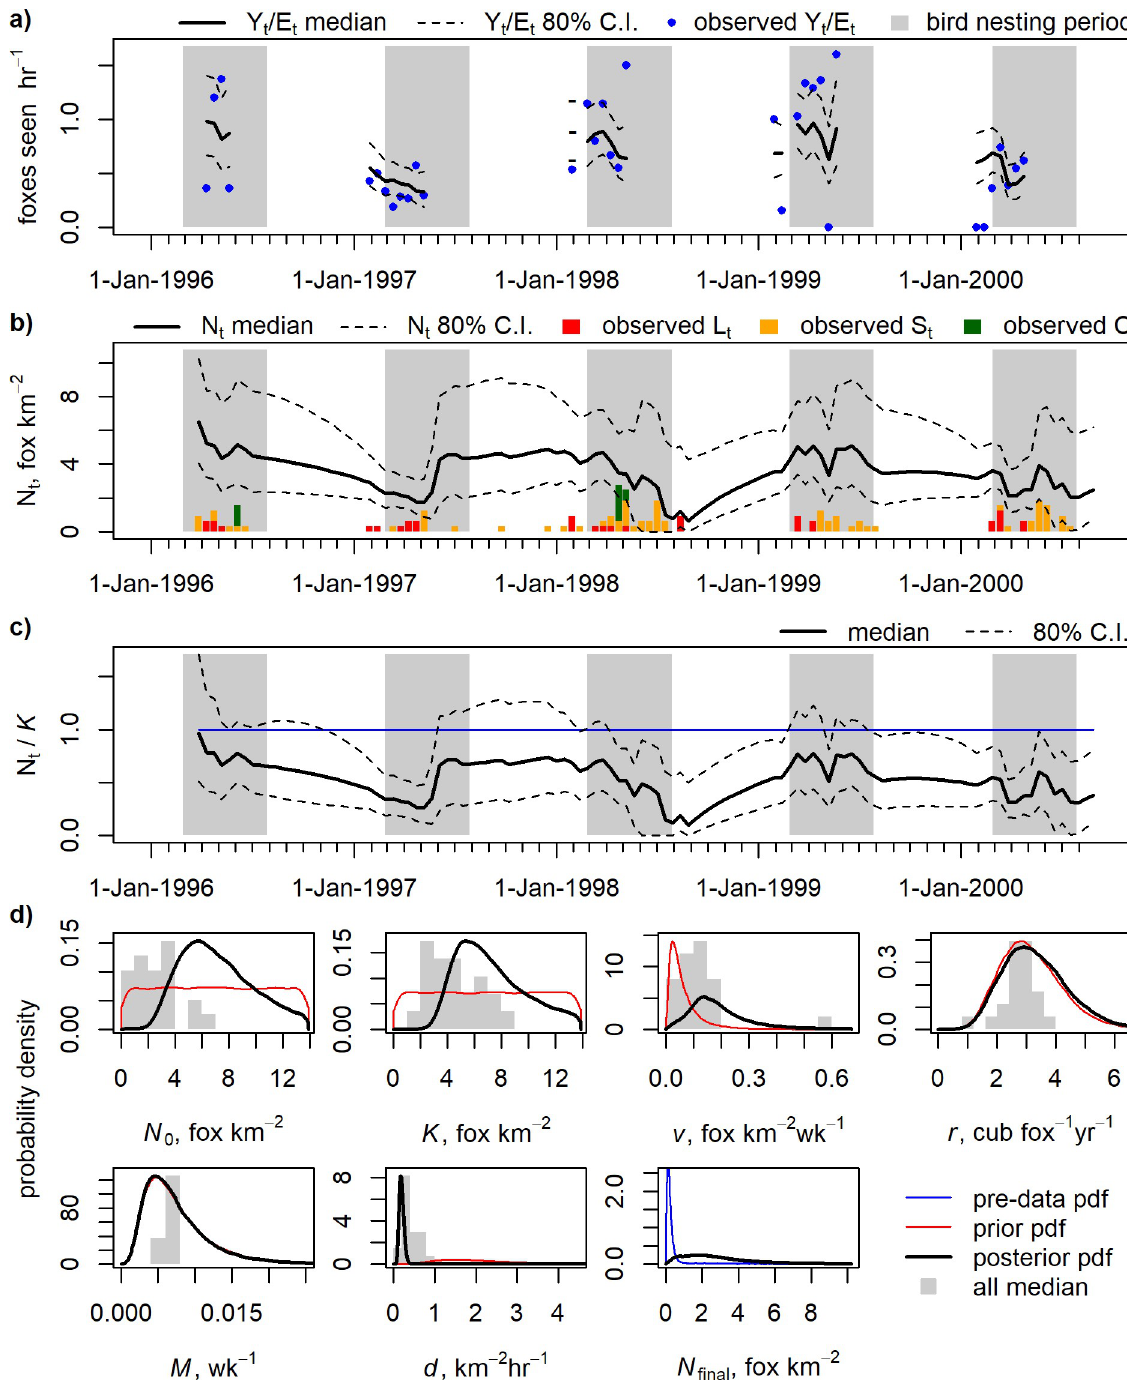
Fig 3. Example results for DLQ. Panel a) shows posterior fit of the model to detection rate ( Y t / E t ). Panel b) shows posterior estimates of bi- weekly fox density ( N t ) in relation to the cull removed by different methods. Panel c) shows estimated N t as a proportion of carrying capacity (blue line denotes median population at posterior median K ). Panel d) shows priors (or post-model-pre-data distribution) and marginal posteriors of N 0 (initial density), K (carrying capacity), v (immigration rate), r ( per capita birth rate), M (instantaneous non-culling mortality rate), d (rate of successful search), and fox density in the final time-step. Histograms in panel d) show posterior medians from all estates. In panels a-c) the bird nesting period (March-July) is shaded grey as a